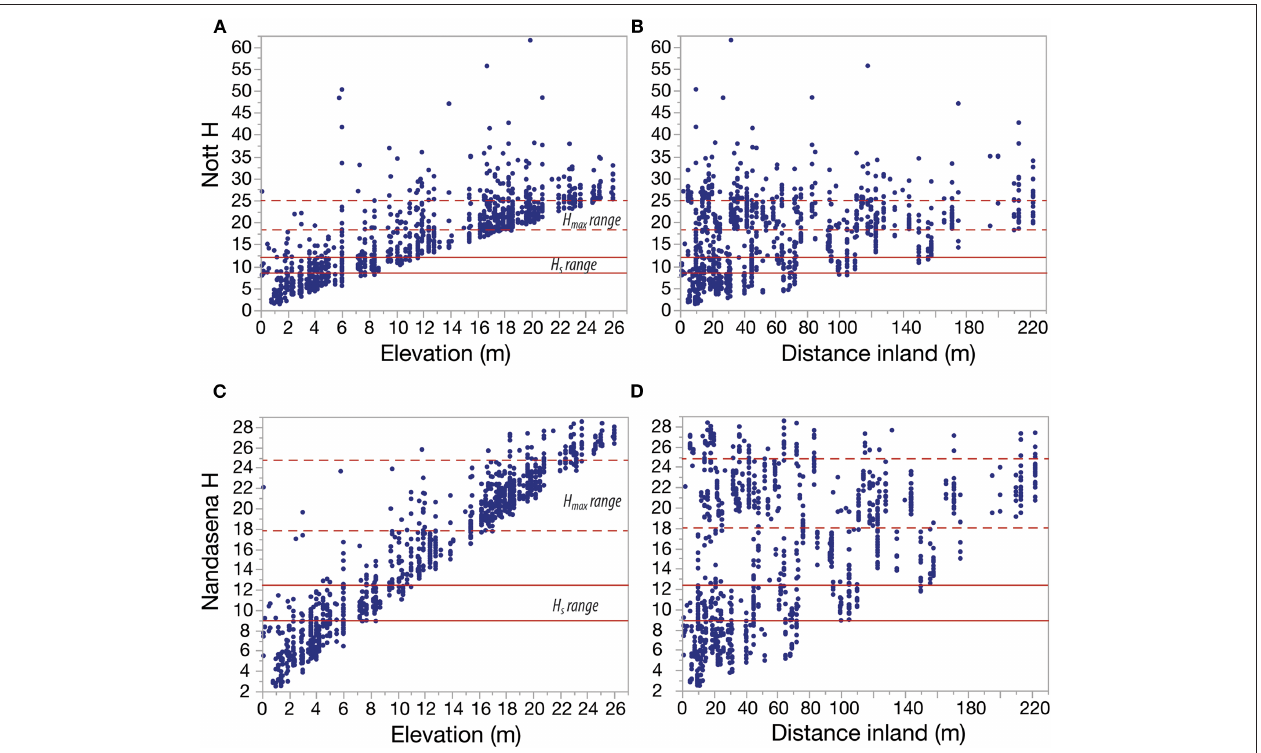
FIGURE 7 | Hindcast wave heights for the Aran Islands in winter 2013-2014, adjusted for topography by adding boulder elevation to the wave height. (A,B) show results for the original Nott (2003b) equation as a function of boulder elevation (A) and location inland of the shoreline (B) . (C,D) show the same relationships for the Nandasena-based equation. The results are displayed as a function of boulder elevation and distance inland. Note that the data have not been corrected for inland decay of wave energy; thus, the heights shown are “minima.” Red horizontal lines show the range of H s (solid red: model outputs from Figure 5 ) and H max (dashed red: estimated as 2 H s ). Note that the H s and H max values would apply only at the coast (i.e., at or near 0m inland on the x-axes in B,D ) and are relative to sea